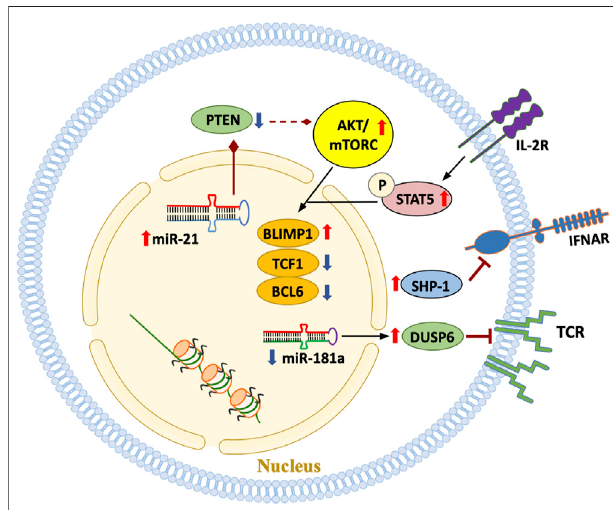
FIGURE 5 | Signaling pathways in aged T cells. A hallmark of the T cell pool in the older adult is the emergence of T cell phenotypes that are functionallyhighlydifferentiated,possiblyduetothereplicativestressimposed by chronic antigenic stimulation and the cytokine milieu. Some T cell subpopulations progress towards end-differentiation. Multiple signaling pathwaysoutlined in this schemehave been implicated in mediatingcytokine- and antigen-derived signals and in determining the response pattern of the T